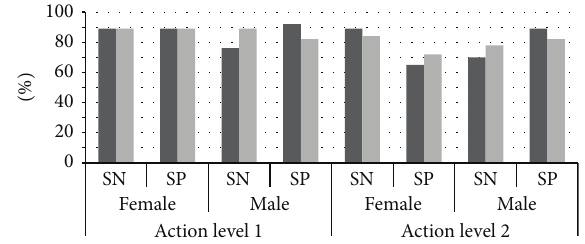
Figure 2: The sensitivity and specificity of the waist circumference cutoff levels recommended by the WHO and the levels calculated from the Turkish population. SN: sensitivity, SP: specificity, bold bars: the criteria of the WHO, The light Bars: The Criteria measured for the Turkish adult